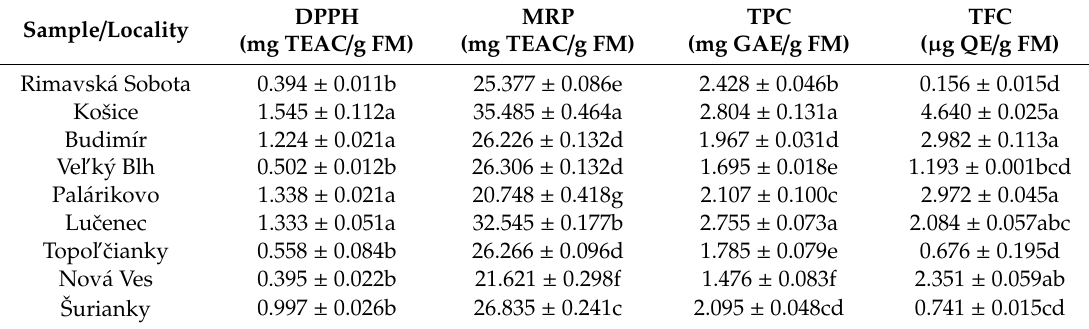
Table 2. Antioxidant activity, total polyphenol and flavonoid content of Ginkgo extract from selected Slovakian